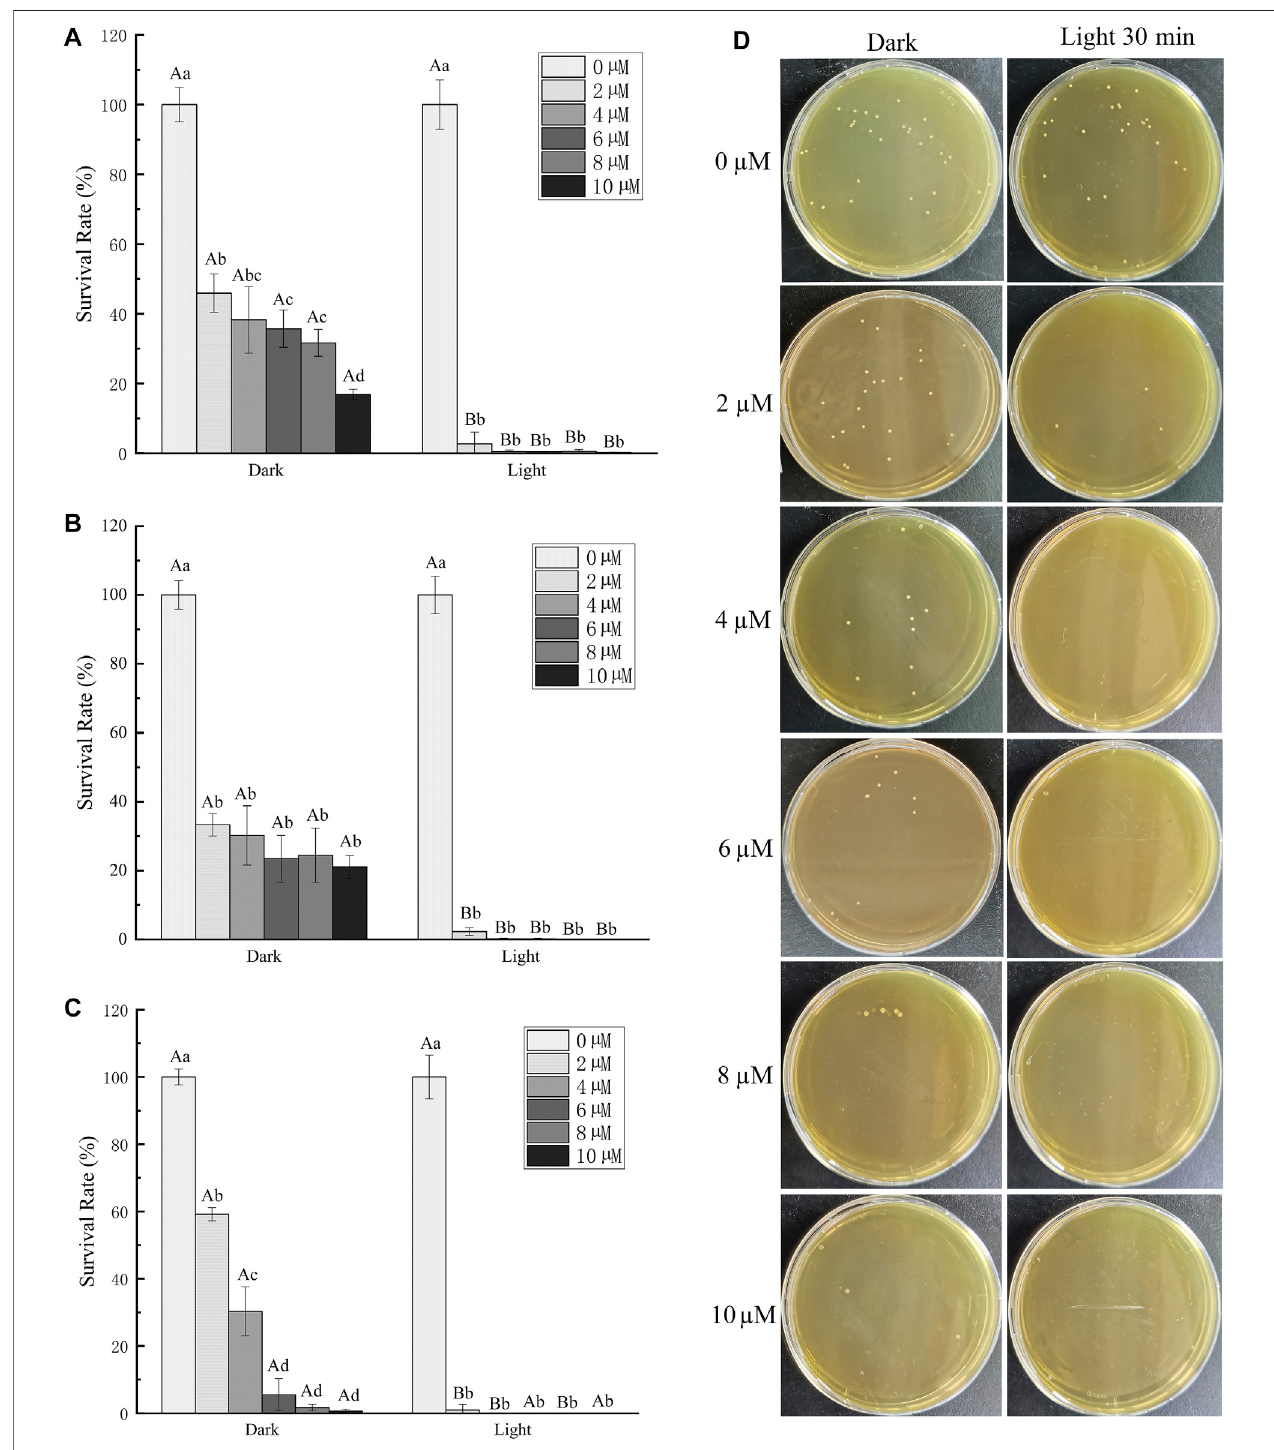
FIGURE 3 | Antibacterial activity of TBP-1 toward GBS. GBS was cultured with TBP-1 at different concentrations for (A) 10 min, (B) 15 min, and (C) 30 min in the dark or under light (4.2 mW cm − 2 ). (D) Plate photographs of GBS on the BHI agar plate incubated with TBP-1 in the dark or under light irradiation (30 min) at various concentrations. Different lowercase letters indicate signi fi cant differences among different concentration groups in the dark or under light ( p < 0.05). Differentuppercase letters indicate signi fi cant differences between dark and light exposure at the same concentration ( p < 0.05).